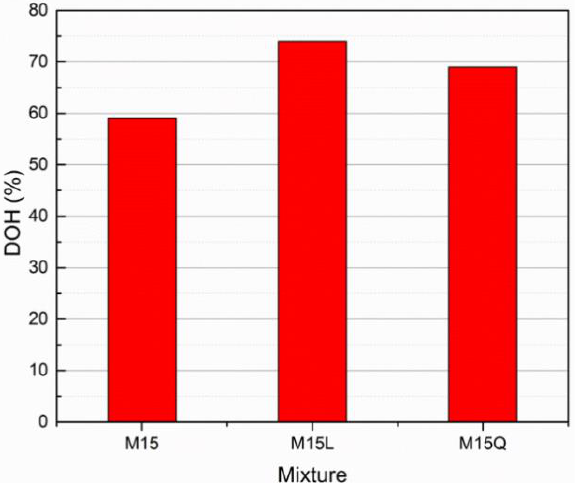
Figure 7. Cement’s Degree of Hydration at 91 days for paste fractions of samples M15, M15L and M15Q.